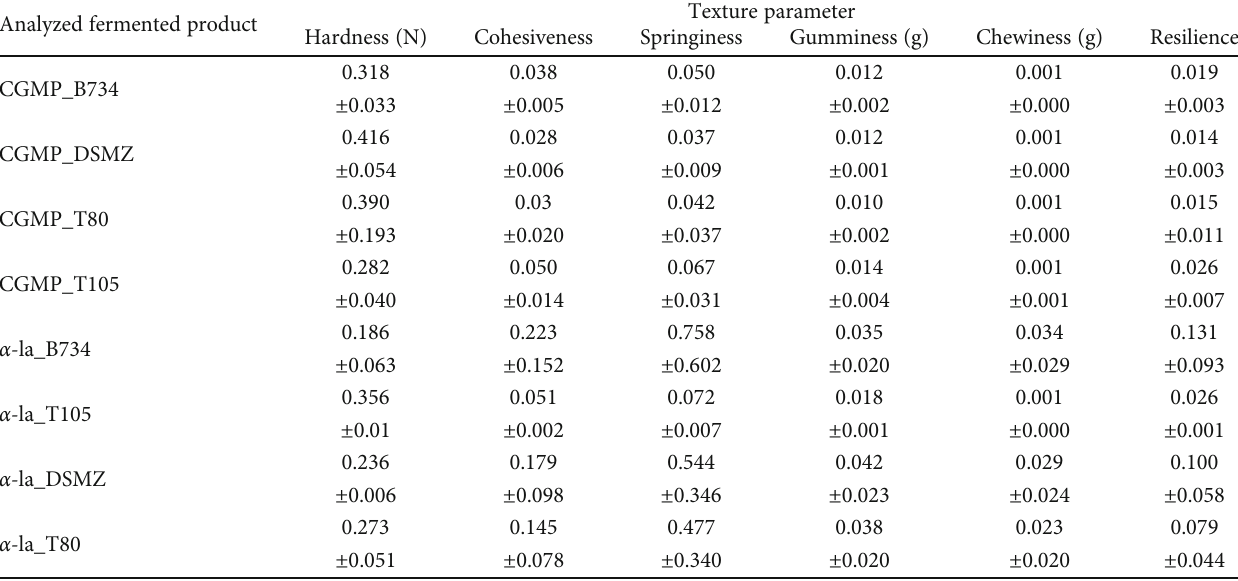
Table 3: Texture parameters for analyzed fermented products.